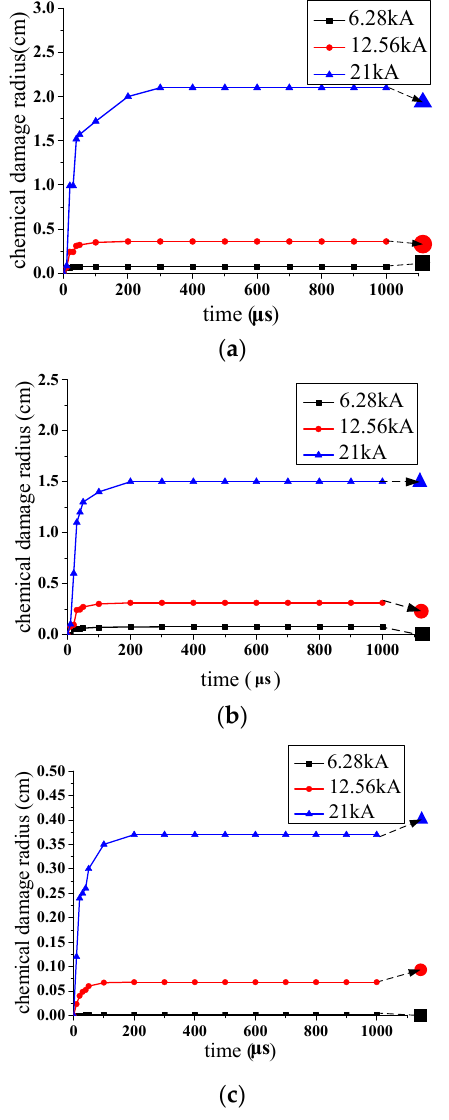
Figure 9. Chemical damage radius of porous materials: ( a ) PVC; ( b ) PET; ( c ) balsa wood.